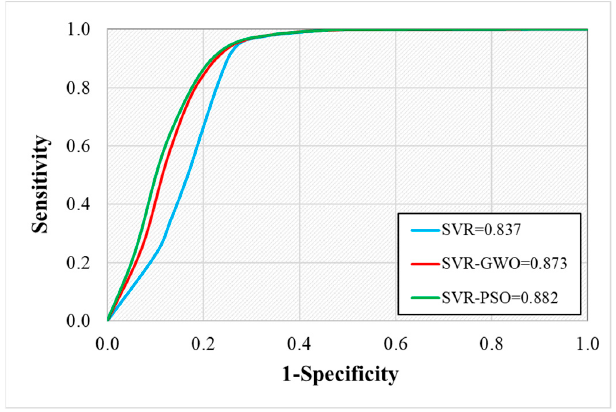
Figure 10. AUC scores and ROC curves of SVR, SVR-GWO, and SVR-PSO using a testing dataset.